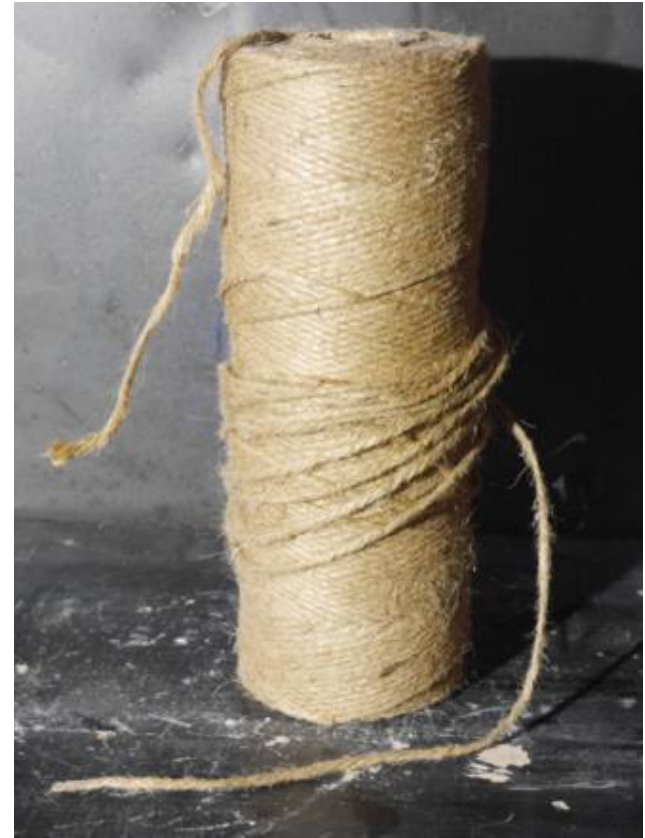
Figure 4. Hemp rope.